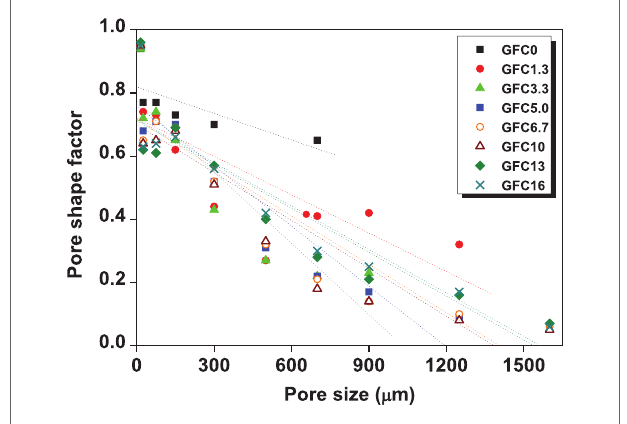
FigUre 7 | average shape factor of pores over averaged pore size .